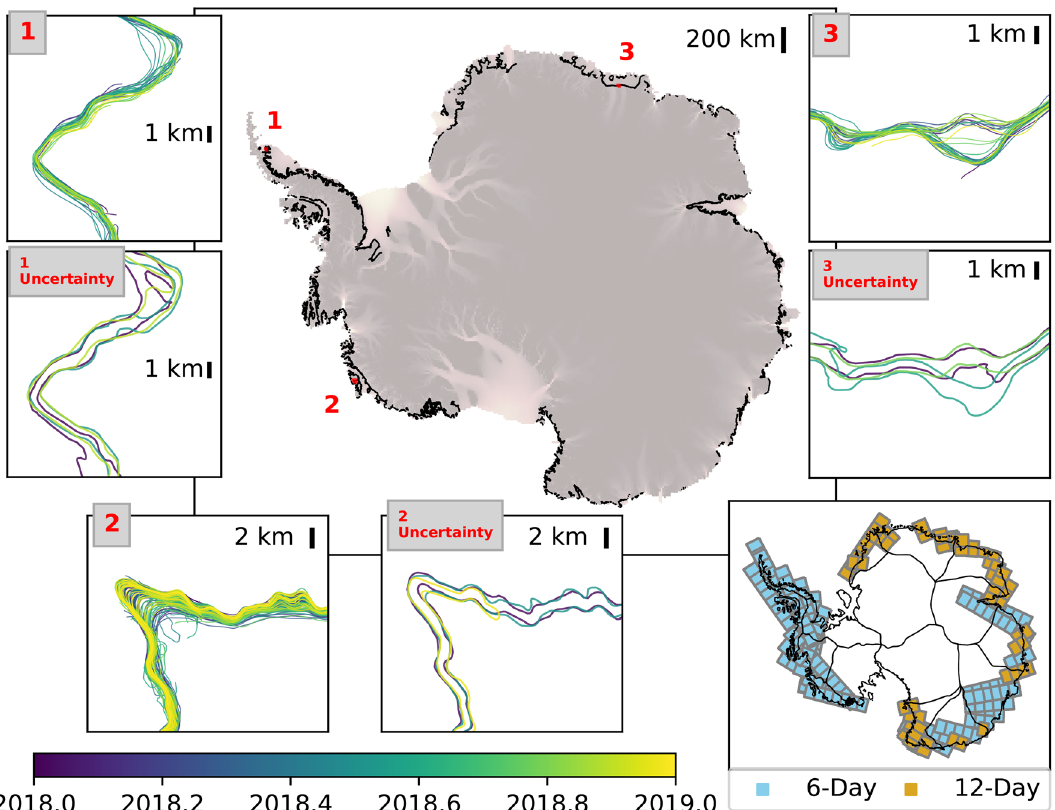
Figure 3. Complete grounding line delineation around the Antarctic Ice Sheet in the year 2018 superimposed on ice velocity; Location of all used Sentinel1-a/b tracks are shown in lower right with 6-day tracks in blue and 12-day tracks in dark orange. The insets show magnified GLs and three representative uncertainties separated by half a year for regions 1, 2 and 3 corresponding to the red boxes in the Peninsula, West Antarctica, and East Antarctica, respectively. The background ice velocity is obtained from the MEaSUREs data product 24–26 and plotted with Rasterio version 1.0.21 18 in Python 3.7.4 17 . The grounding lines and basin outlines in the insets are plotted with Matplotlib version 3.3.2 19 in Python 3.7.4 17 . The basins are divided according to the Rignot drainage basin divisions 1,27–30 . The track information is plotted using Geopandas version 0.6.1 31 in Python 3.7.4 17